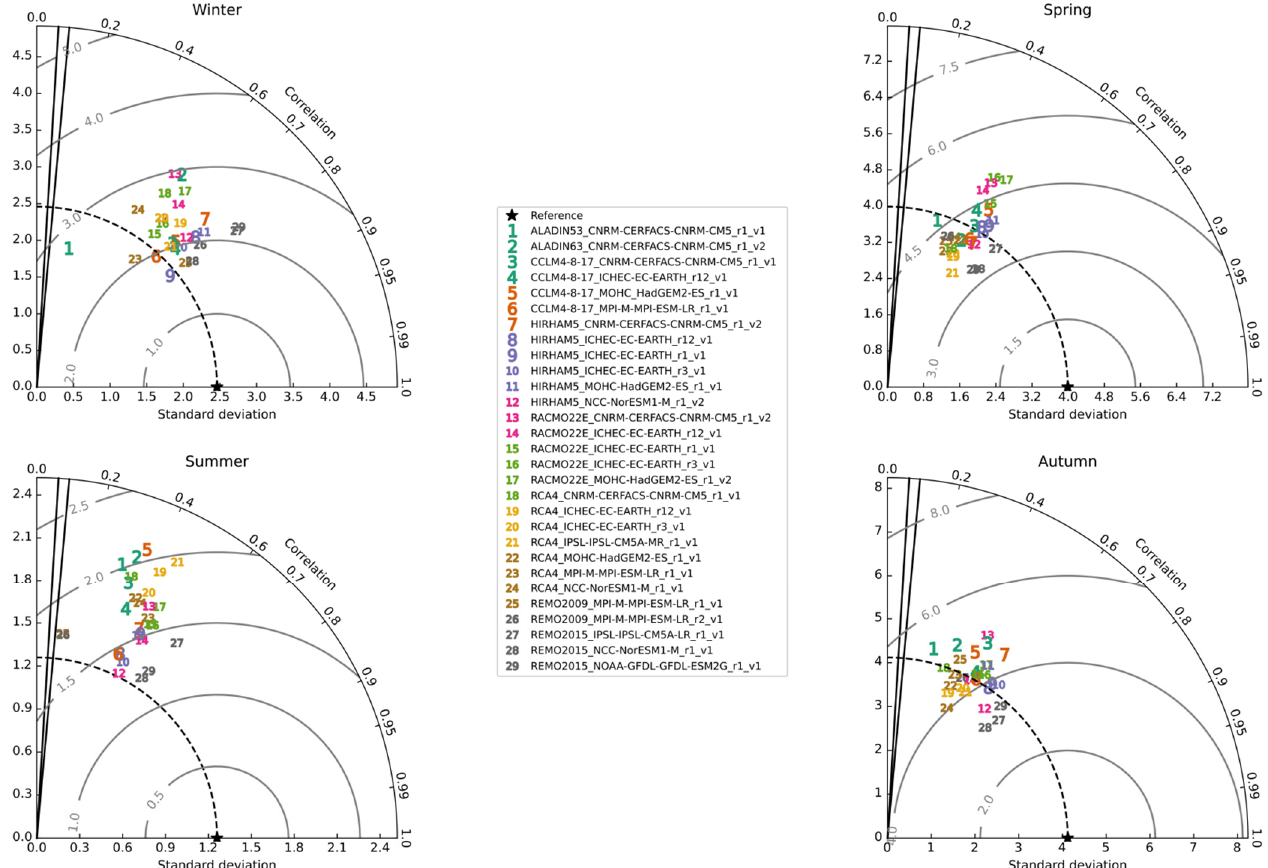
Figure 11. Taylor diagrams of seasonal (1971–2000) minimum temperature showing standard deviation (°C), centered RMSE (°C), and spatial correlation for each EURO-CORDEX GCM–RCM simulation versus E-OBS observations across the Pannonian Basin. The four panels refer to the four seasons defined as winter (DJF), spring (MAM), summer (JJA), and autumn (SON). The observed field is labeled with a star symbol. The dotted line depicts the contour of the reference standard deviation (the observed field). The RMSE contours are grayed out. The 95th and 99th significance levels are represented by the correlation rays on the left and right, respectively. Table 2. Temperature trends averaged over the Pannonian Basin of the EURO-CORDEX RCMs and E-OBS during the 1970–2005 period.